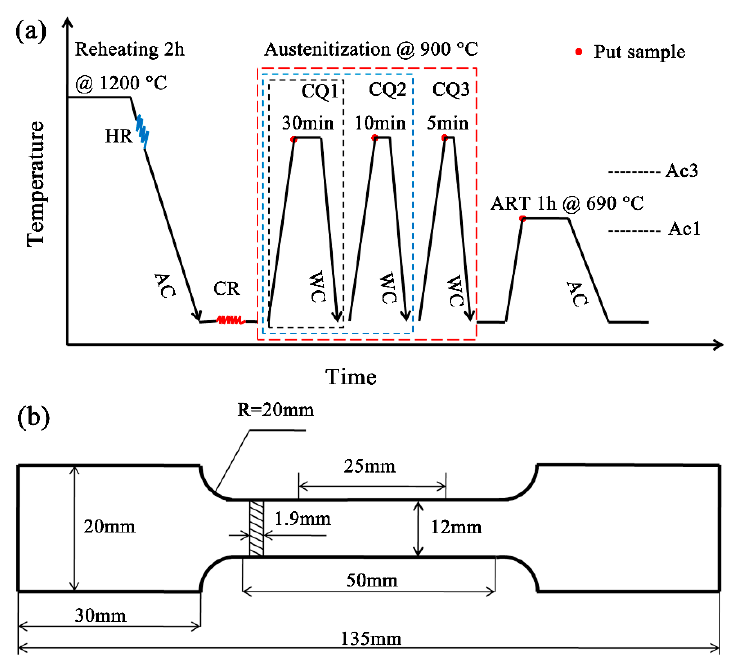
Figure 1. ( a ) Schematic diagram of the different heat treatment process; ( b ) specimen for tensile tests.